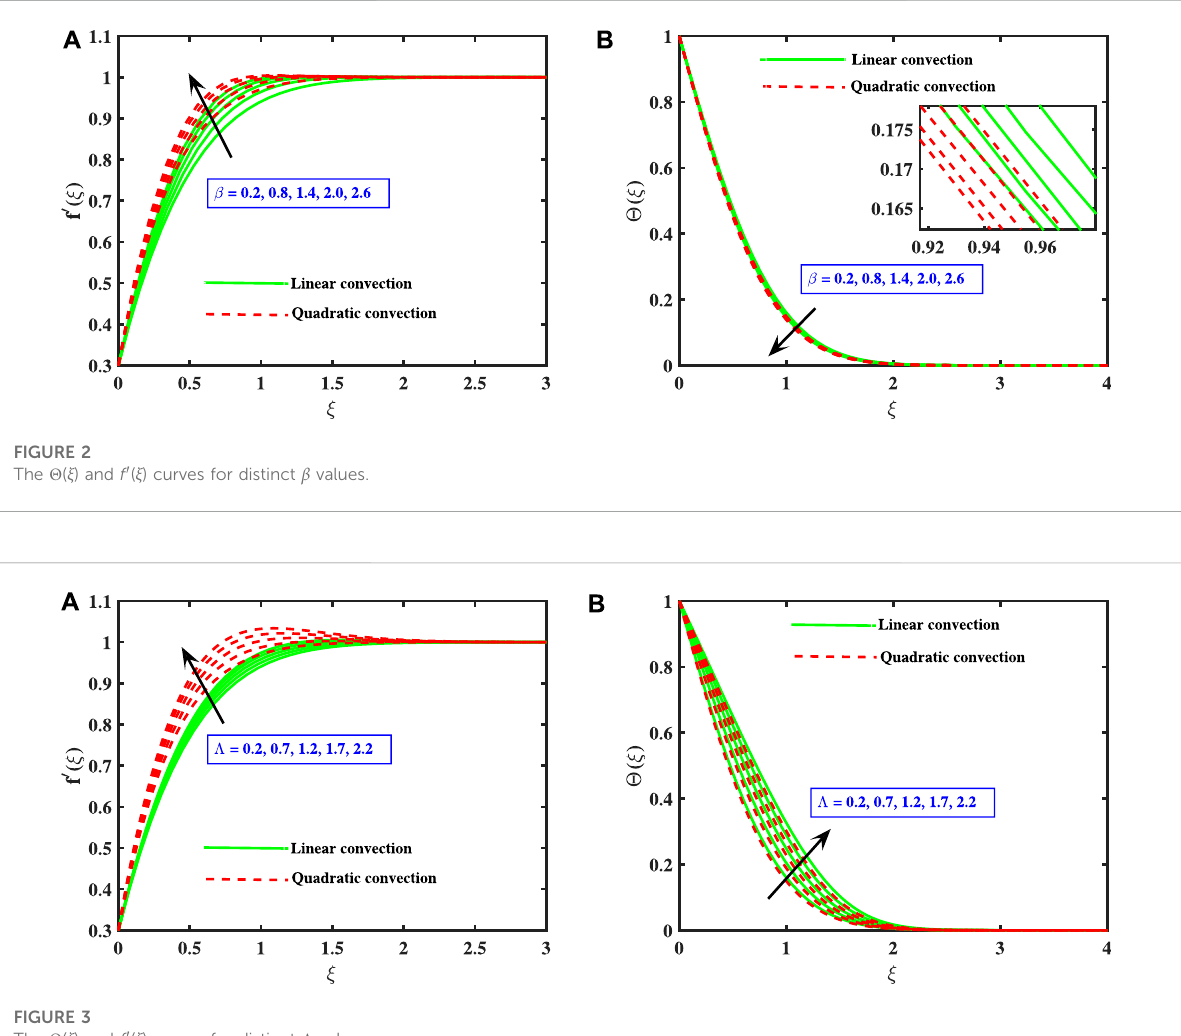
FIGURE 3 The Θ ( ξ ) and f ′ ( ξ ) curves for distinct Λ